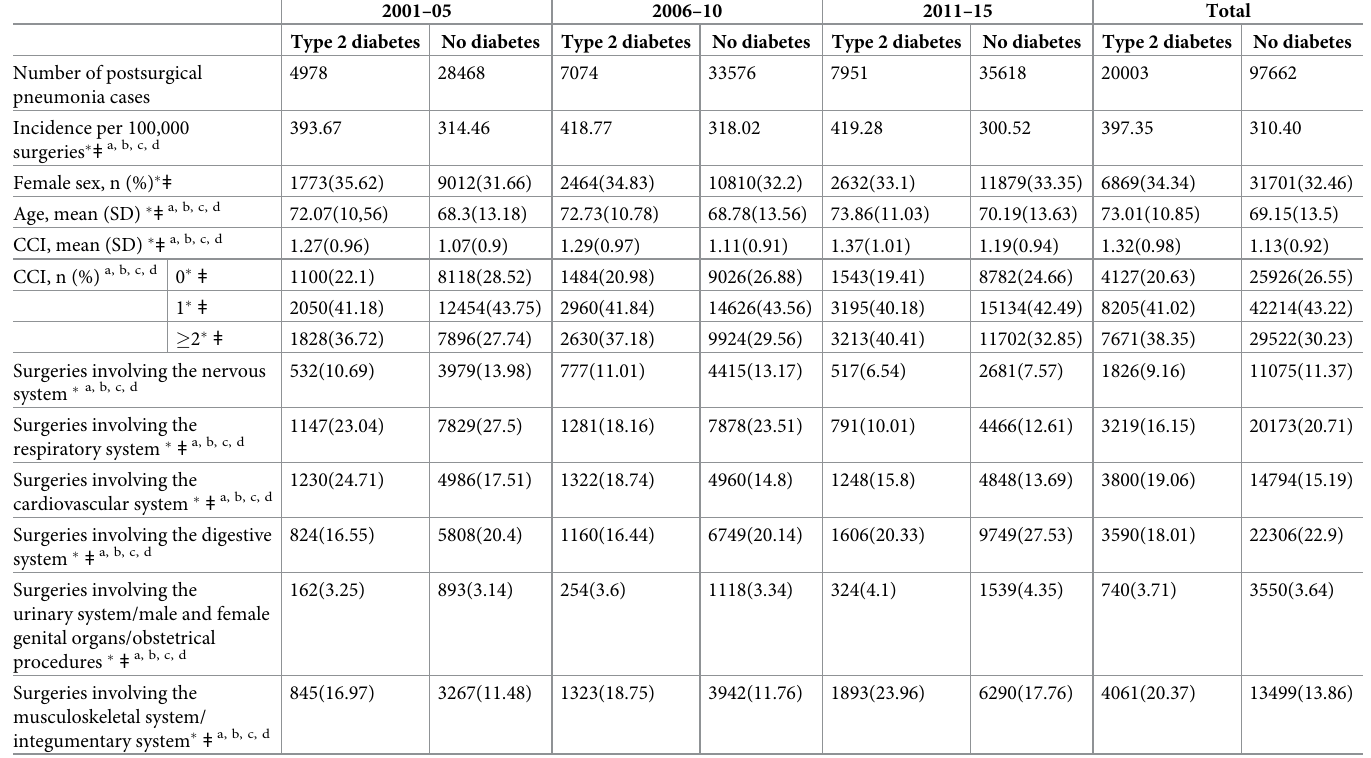
Table 1. Sociodemographic and clinical characteristics of hospitalized patients who suffered from postsurgical pneumonia in Spain from 2001 to 2015 according to diabetes